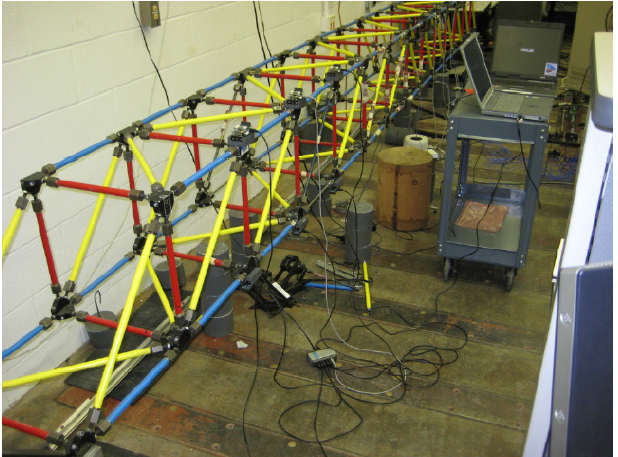
Figure 9. Truss structure in experiment test [158].